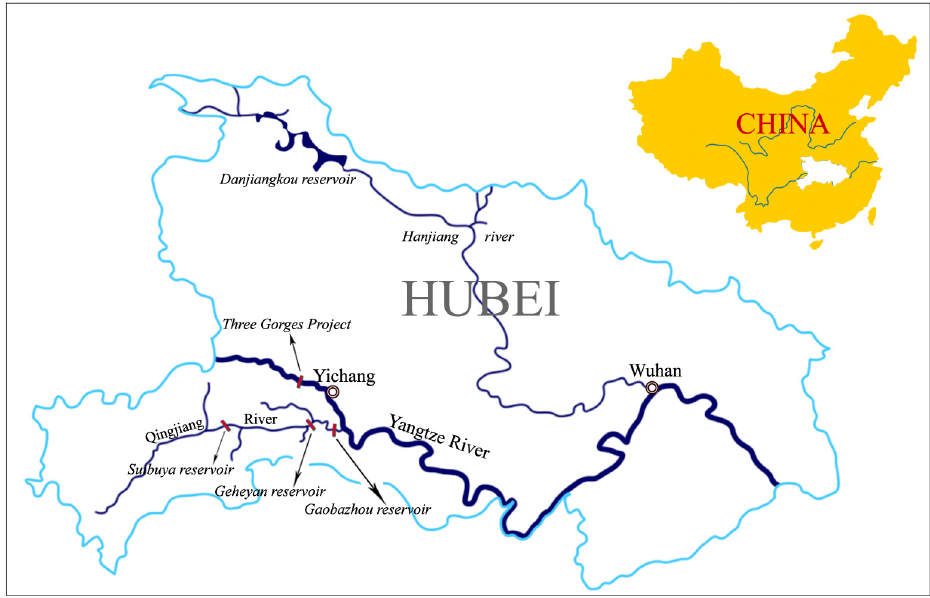
Figure 4. Map showing the location of the Geheyan Hydropower plant in China.